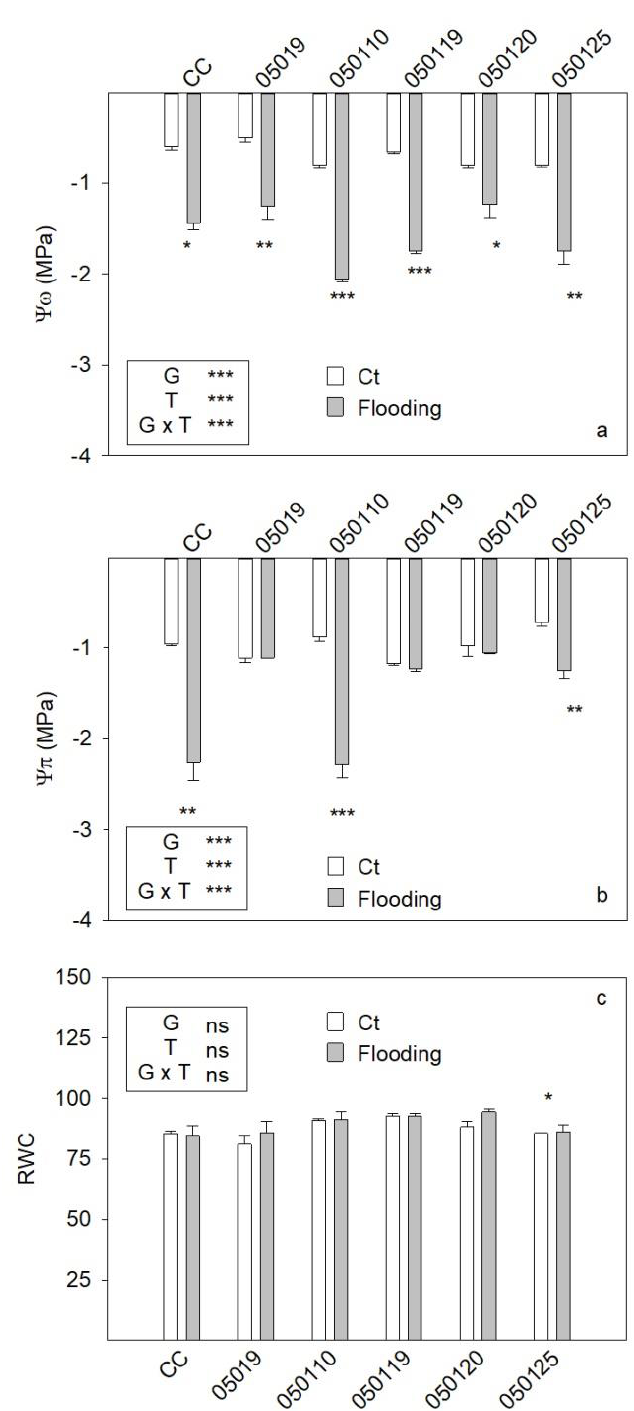
Figure 6. ( a ) Water potential ( Ψ ω ), ( b ) osmotic potential ( Ψ π ), and ( c ) RWC (relative water content) in the leaves of five citrus hybrids grown for 35 days in the non -tressed (Ct) or flooding treatment. Values are the means of six independent seedlings ( n = 6). In each hybrid, comparisons among treatments were made by Fisher’s least significance difference (LSD) test. * p < 0.05, ** p < 0.01, *** p < 0.001, ns: not significant. CC: Carrizo citrange; G: genotype, T: treatment.